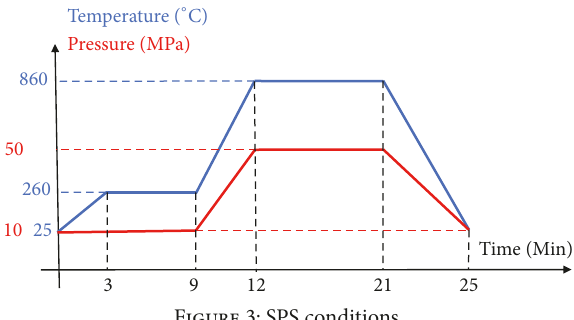
Figure 6 after SPS and after IATD test. EDS color